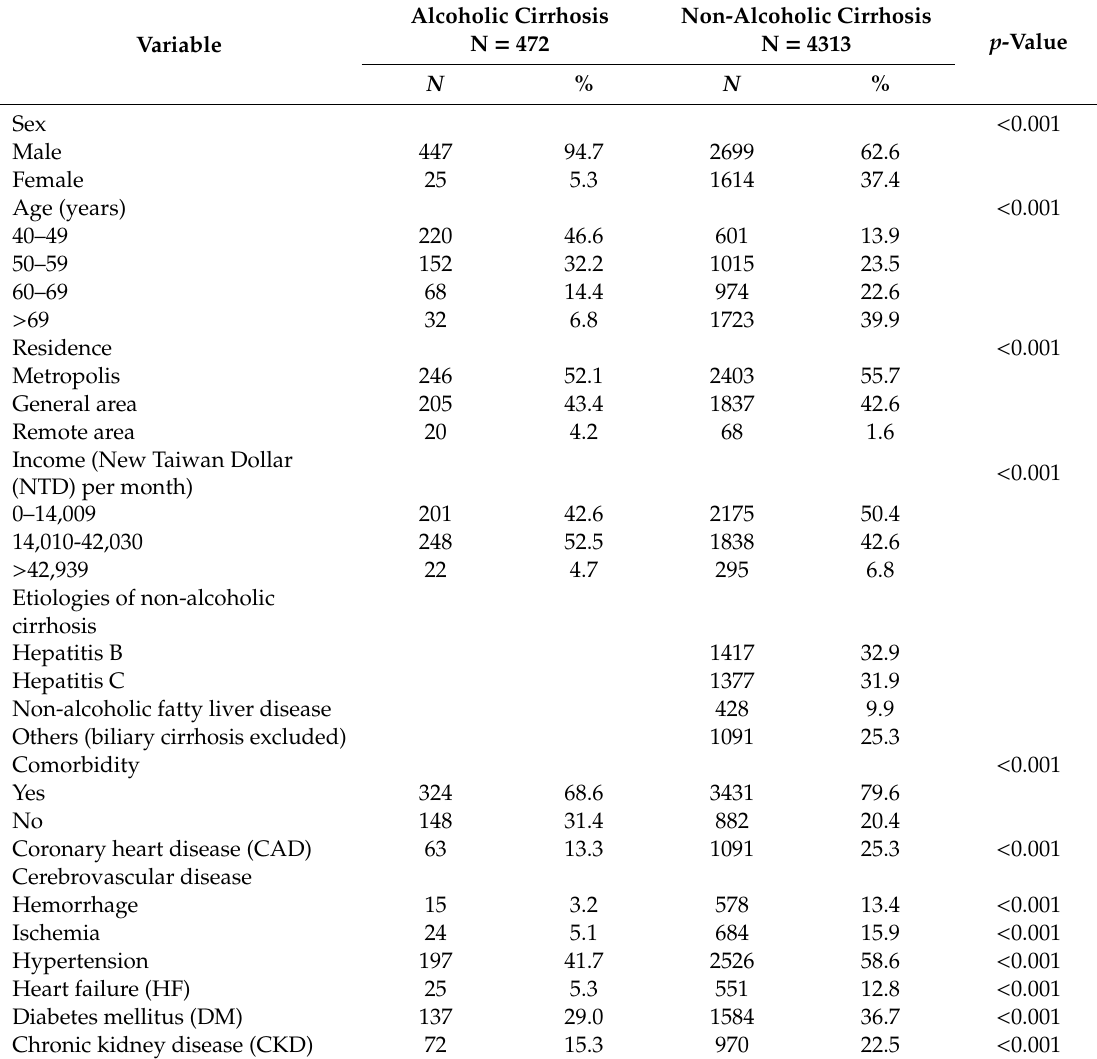
Table 1. Baseline characteristics of study